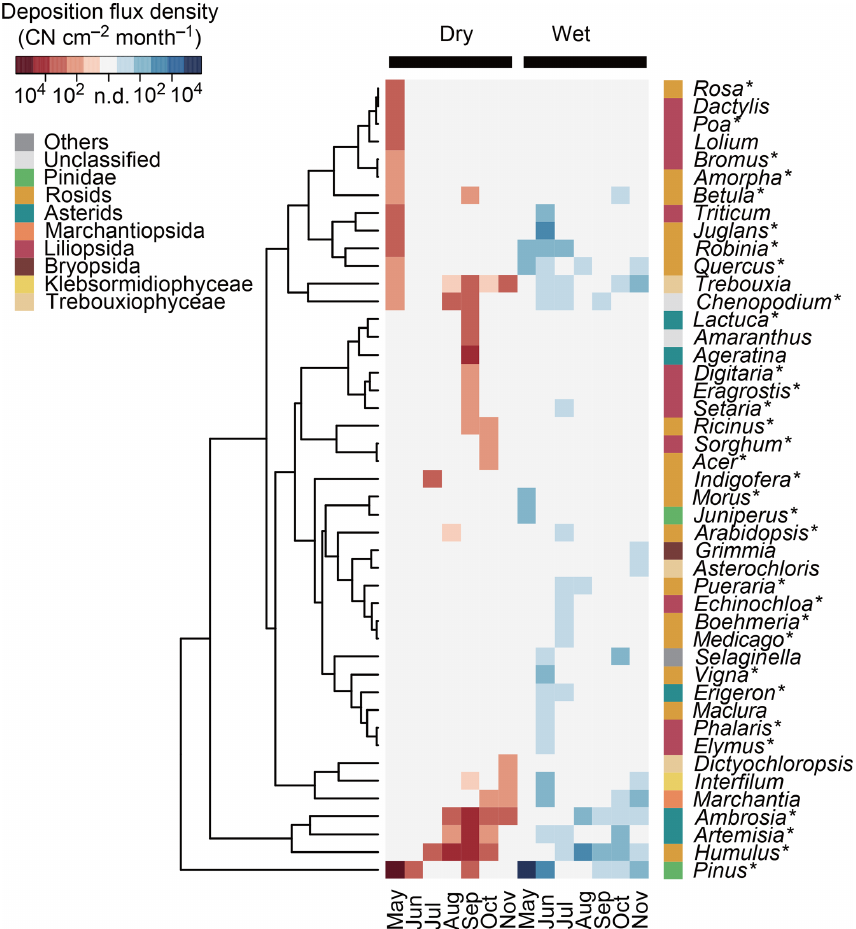
Figure 4. Deposition flux densities of plant genera in terms of copy number (CN) of ITS2 in Seoul in South Korea. The 30 most abundant plant genera in dry and/or wet deposition are shown. Asterisks ( ∗ ) indicate the spermatophyte genera that are known to inhabit South Korea and that are listed in the databases of the Korea National Arboretum (2017) and/or the Korea Research Institute of Bioscience and Biotechnology (2016). The tree represents the similarities, based on Euclidean distance, of the log-transformed deposition flux